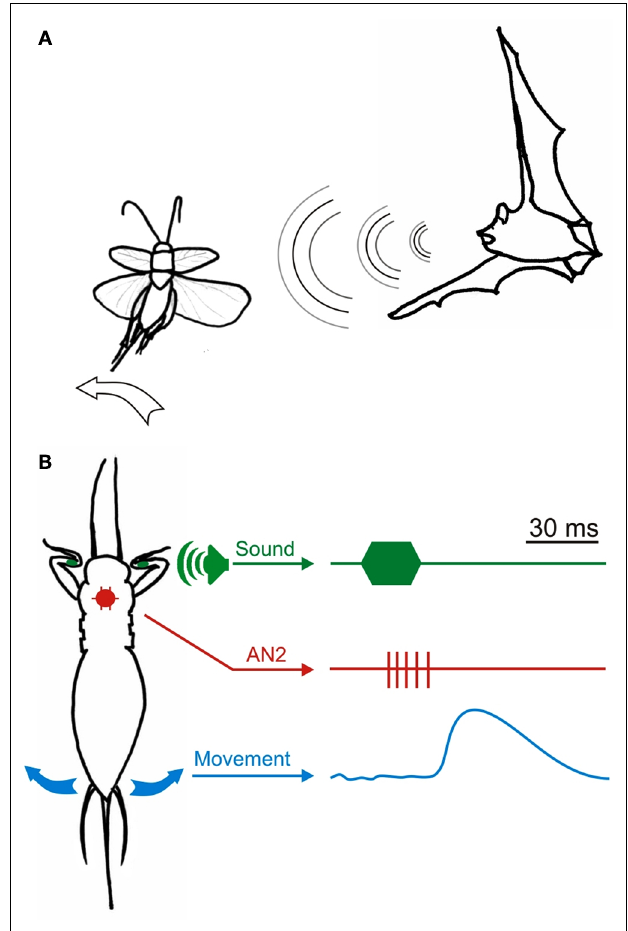
FIGURE 3 | Studying the neural basis of ultrasound avoidance. (A) Ultrasound pulses such as the ones produced by foraging insectivorous bats cause avoidance steering in flying crickets directed away from the sound source.The steering movements consist of changes in the wingbeat pattern but also of movements of the abdomen, hindlegs and antennae in the direction of the intended turn. (B) Tethered crickets continue to produce the motor pattern of flight and can thus be stimulated with ultrasound while the neural and/or motor output is recorded (Nolen and Hoy, 1984, 1986; Marsat and Pollack, 2006,